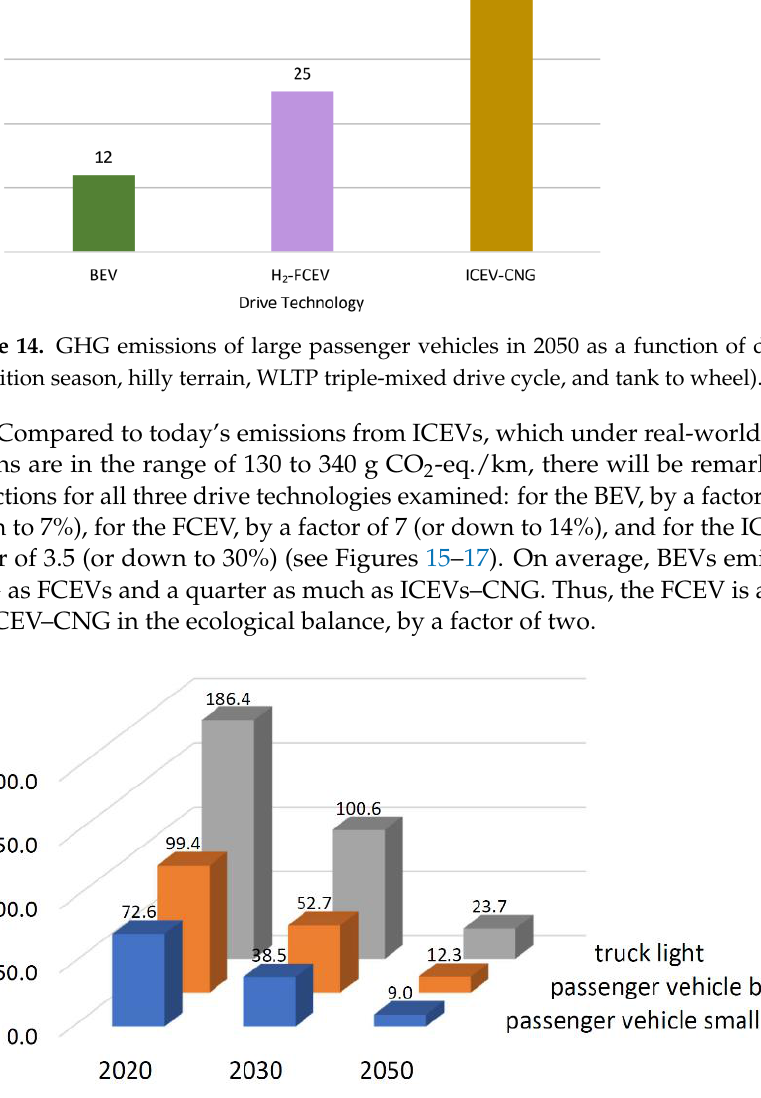
Figure 15. GHG emissions of BEVs until 2050 (tank to wheel).